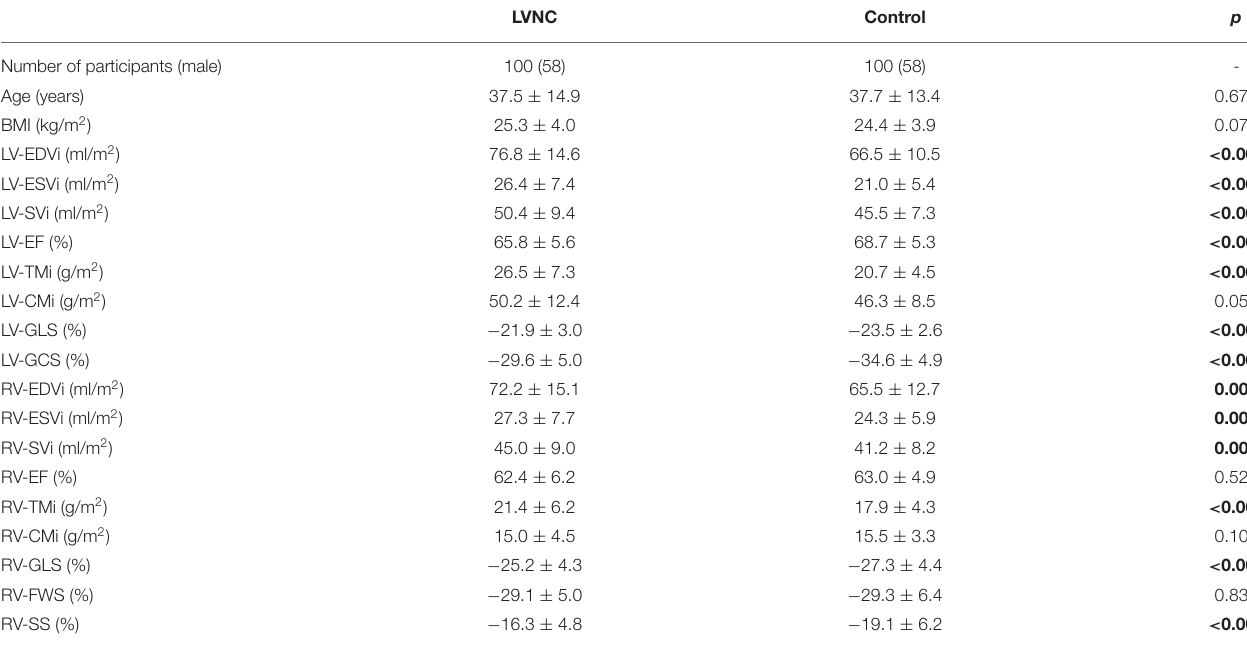
TABLE 1 | Baseline characteristics of the study